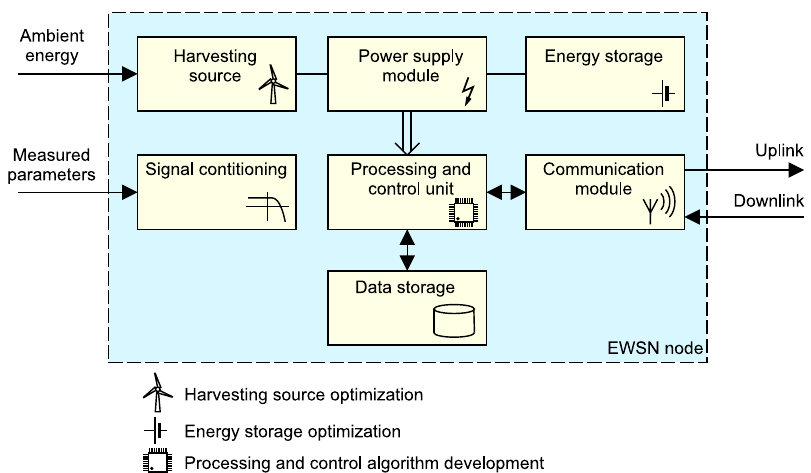
Figure 7. Node block diagram with highlighted research challenges: harvesting source and energy storage optimization, algorithms for processing and control